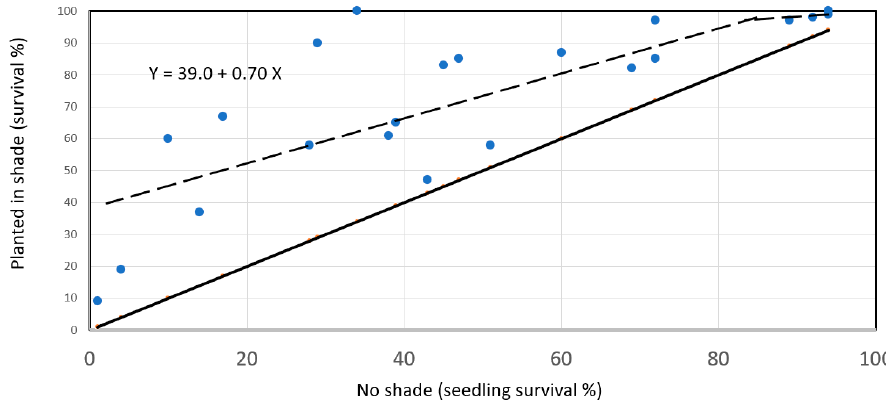
Figure 24. At reforestation sites in Oregon, shade can increase the survival of shade-tolerant Douglas-fir seedlings. Data from [165–168]. The dashed line represents the regression equation ( n = 22) and the solid line represents no benefit from shade. Points above the solid line represent sites where shade increased survival. p > |t| = 0.0001 for intercept and 0.0001 for slope; R 2 = 0.61.